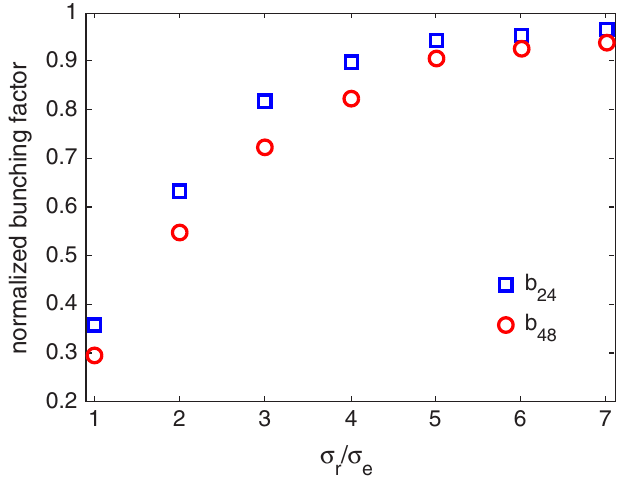
FIG. 8. (Color) Normalized bunching factors for b 24 (blue sym- bols) and b 48 (red circles) as functions of the ratio (cid:2) r =(cid:2) e